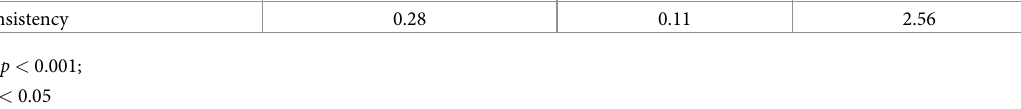
Table 2. Summary of the fixed effects in the mixed effect linear regression model incorporating test consistency for Experiment 1, with test trials in the last block dropped.